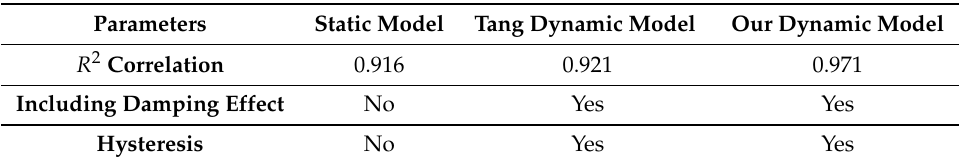
Table 1. Comparison between different PAM